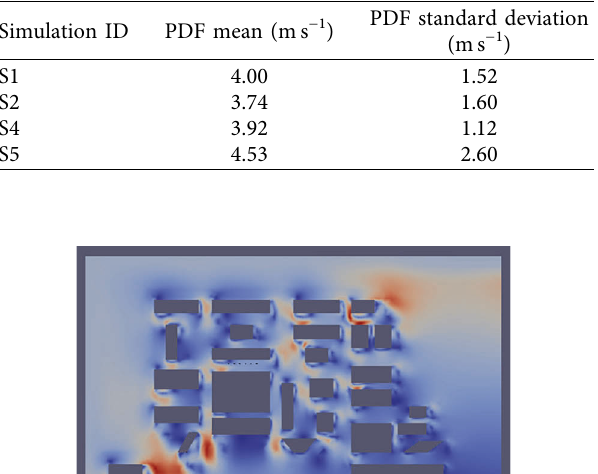
Figure 9: Horizontal slice at a height of 4 m of the relative dif- ference between the wind speeds simulated using S5 and